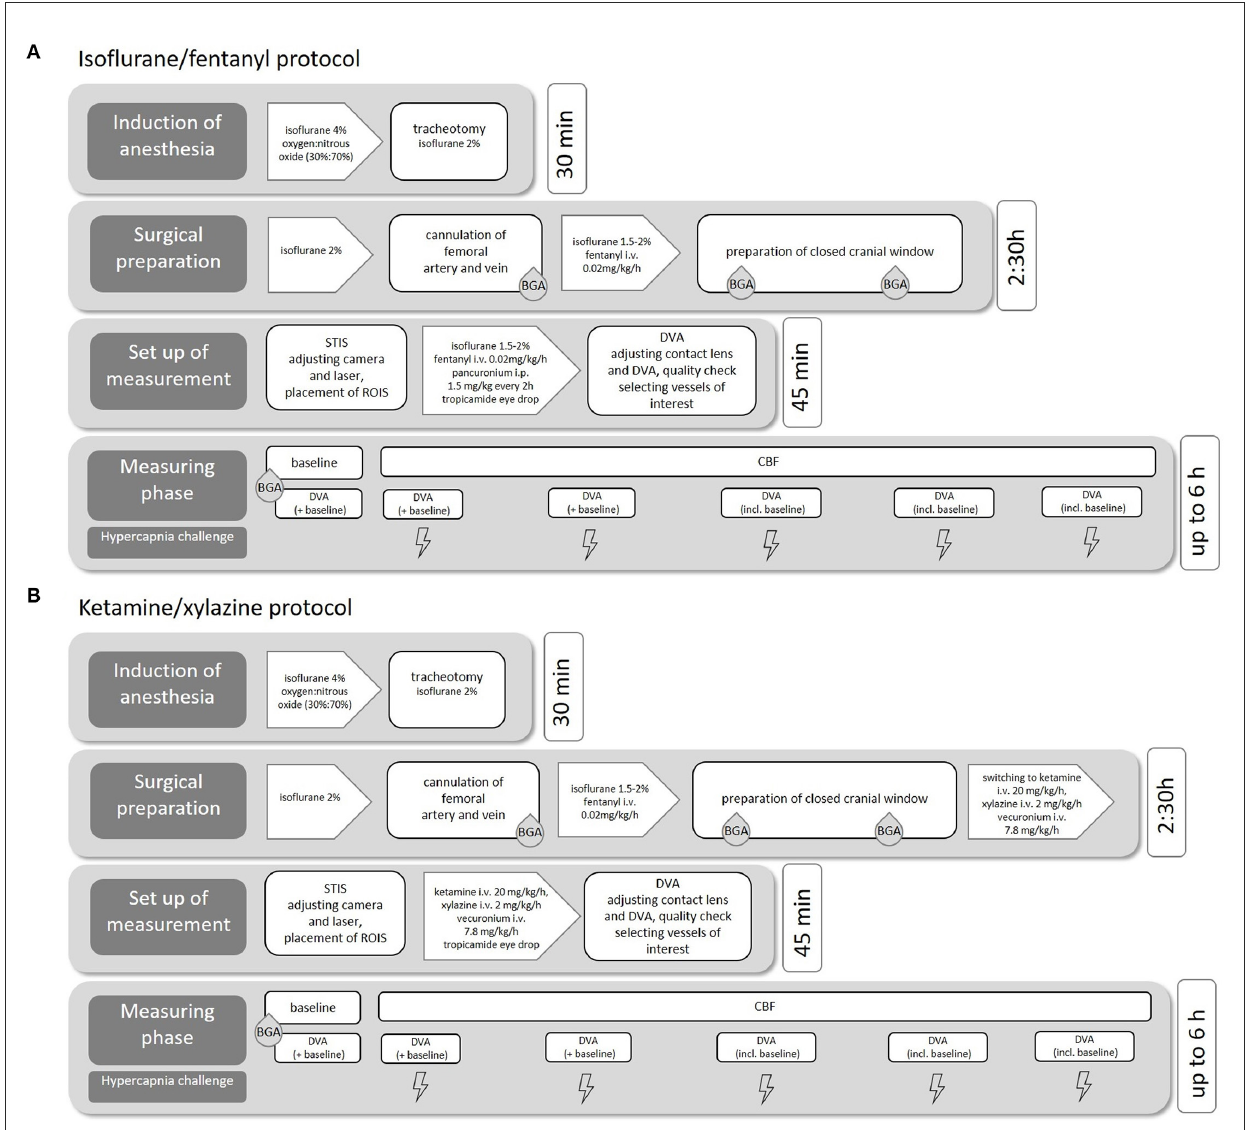
FIGURE1 Experimental procedure. Flowchart of the individual surgical steps including medication and estimated duration for isoflurane/fentanyl anesthesia (A) and ketamine/xylazine anesthesia (B)